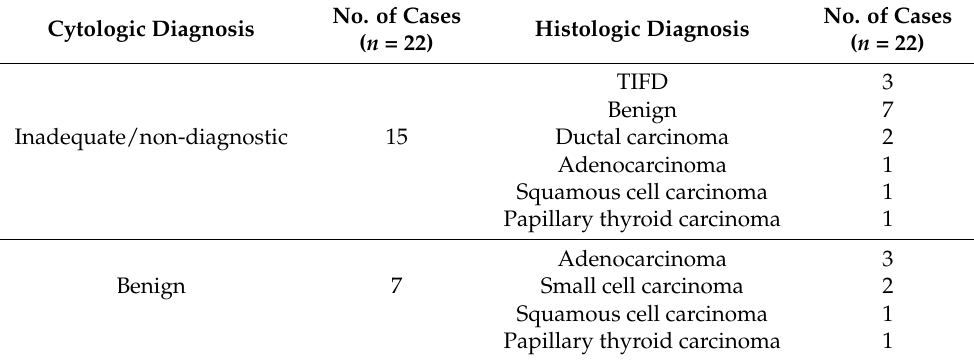
Table 4. Histologic diagnoses of FNAC sampling error cases.